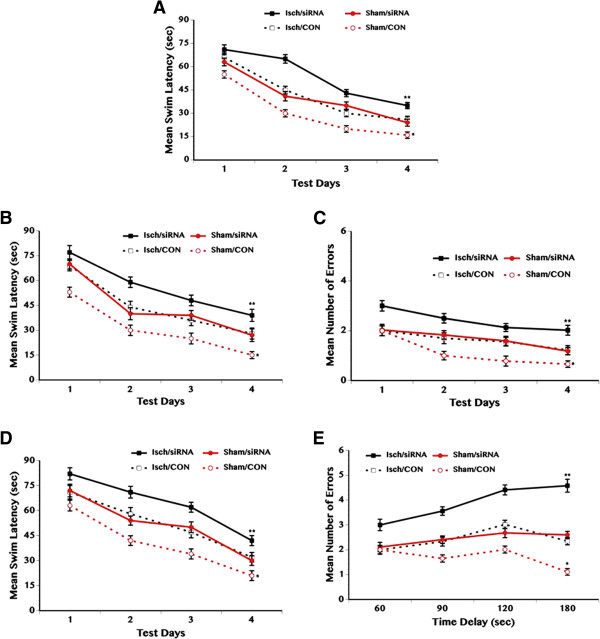
CX3CR1 deficiency cause cognitive impairment. Transient global cerebral ischemia resulted in increased mean swim latency in the cued learning task (A), discrimination learning task (B), and delayed non-matching-to-sample task (D) compared to the sham control group. Ischemic rats also made more error in the discrimination learning task (C) and delayed non-matching-to sample task (E) when compared to the sham control animals. However, CX3CR1 deficiency in the ischemic rats exacerbated their impaired behavioral performance in the cued learning, discrimination learning, and delayed non-matching-to-sample task. CX3CR1 deficiency in the sham rats also resulted in impaired behavioral performance in the three cognitive tasks.*P <0.05 and **P <0.01.